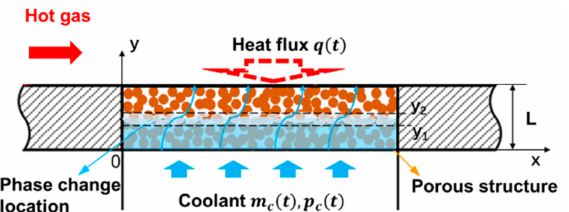
Figure 1. Physical model of transient two-phase flow with phase change in porous